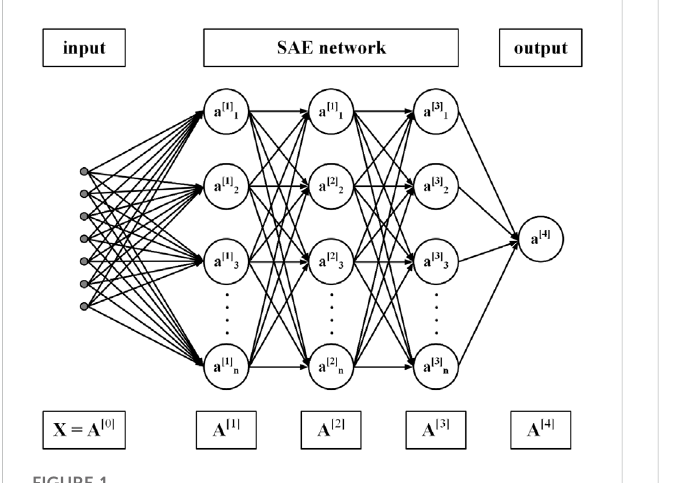
FIGURE 1 Structure of stacked autoencoder network.